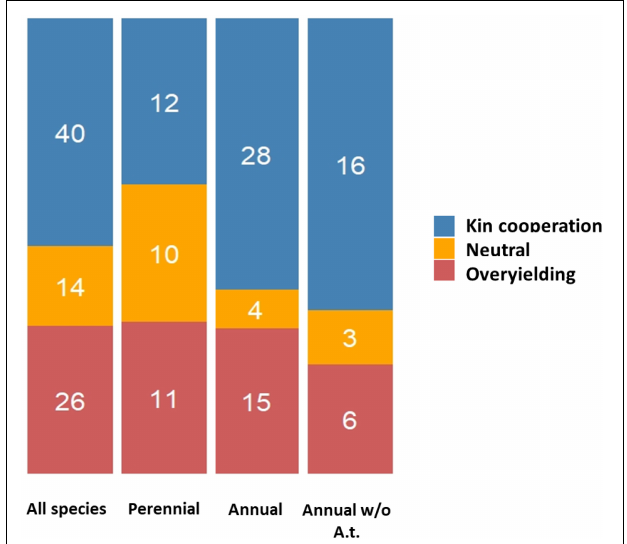
FIGURE 6 | Stacked barplots illustrating the different outcomes of GxG interactions according to the annual vs. perennial strategy of species studied (with and without including Arabidopsis thaliana ). The number of studies supporting each type of interaction are indicated within each